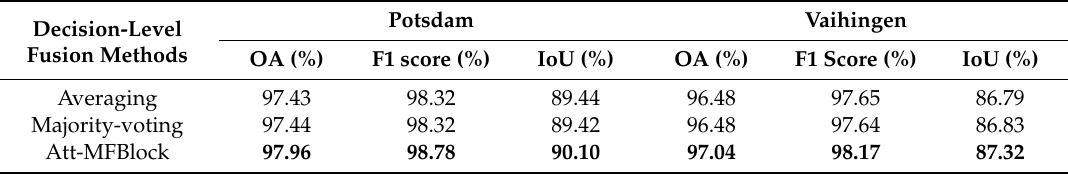
Table 5. Quantitative results of di ff erent decision-level fusion